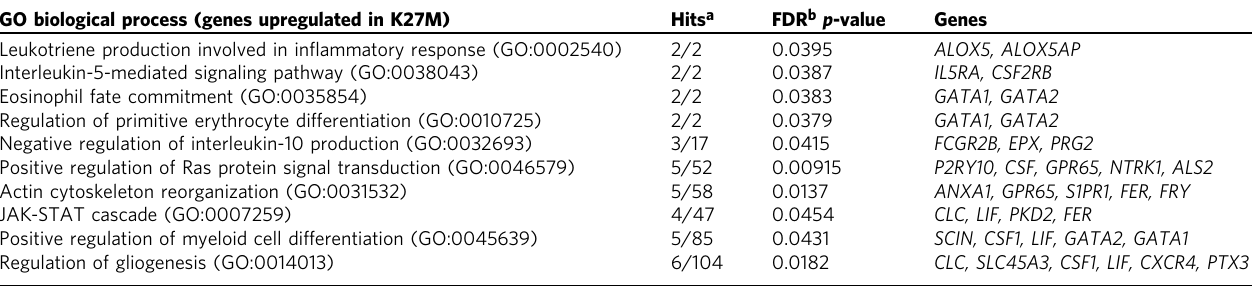
Table 4 Gene ontology enrichment analysis of signi fi cantly upregulated genes in cells overexpressing K27M compared to